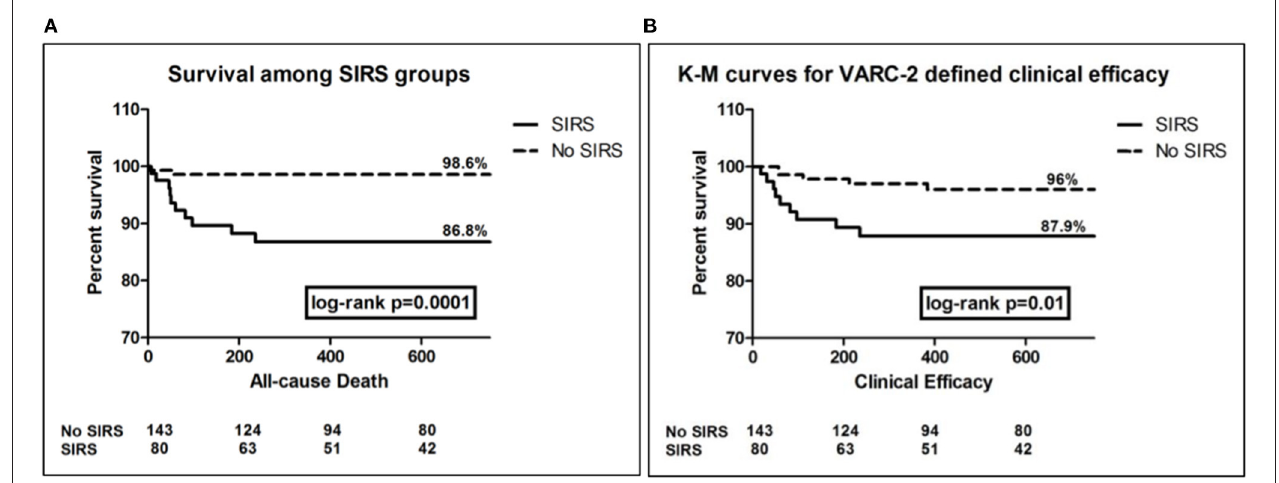
FIGURE 2 | Kaplan Meier survival curves for the outcomes of all-cause death (A) , and clinical efficacy composite end-point (B) , showing significantly more events among SIRS group, log rank p = 0.0001, and 0.01,